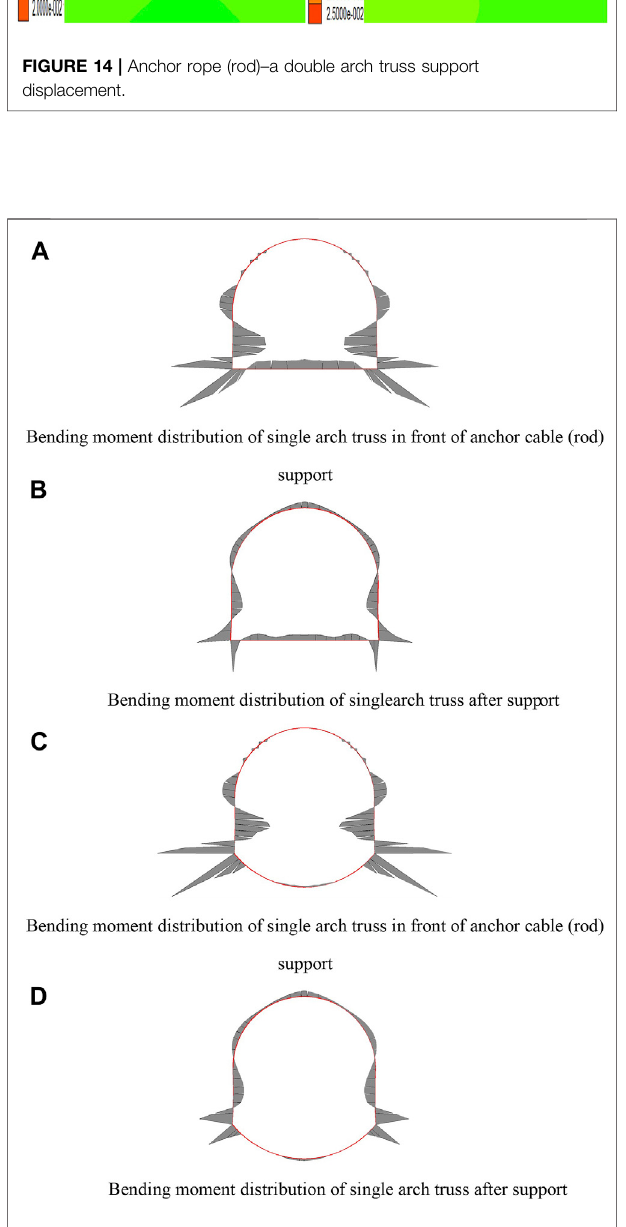
FIGURE 15 | Bending moment distribution of the structure. (A) Bending moment distribution of single arch truss in front of the anchor cable (rod) support. (B) Bending moment distribution of the single arch truss after support. (C) Bending momentdistribution ofthesinglearchtrussinfront of the anchor cable (rod) support. (C) Bending moment distribution of the single arch truss after support.